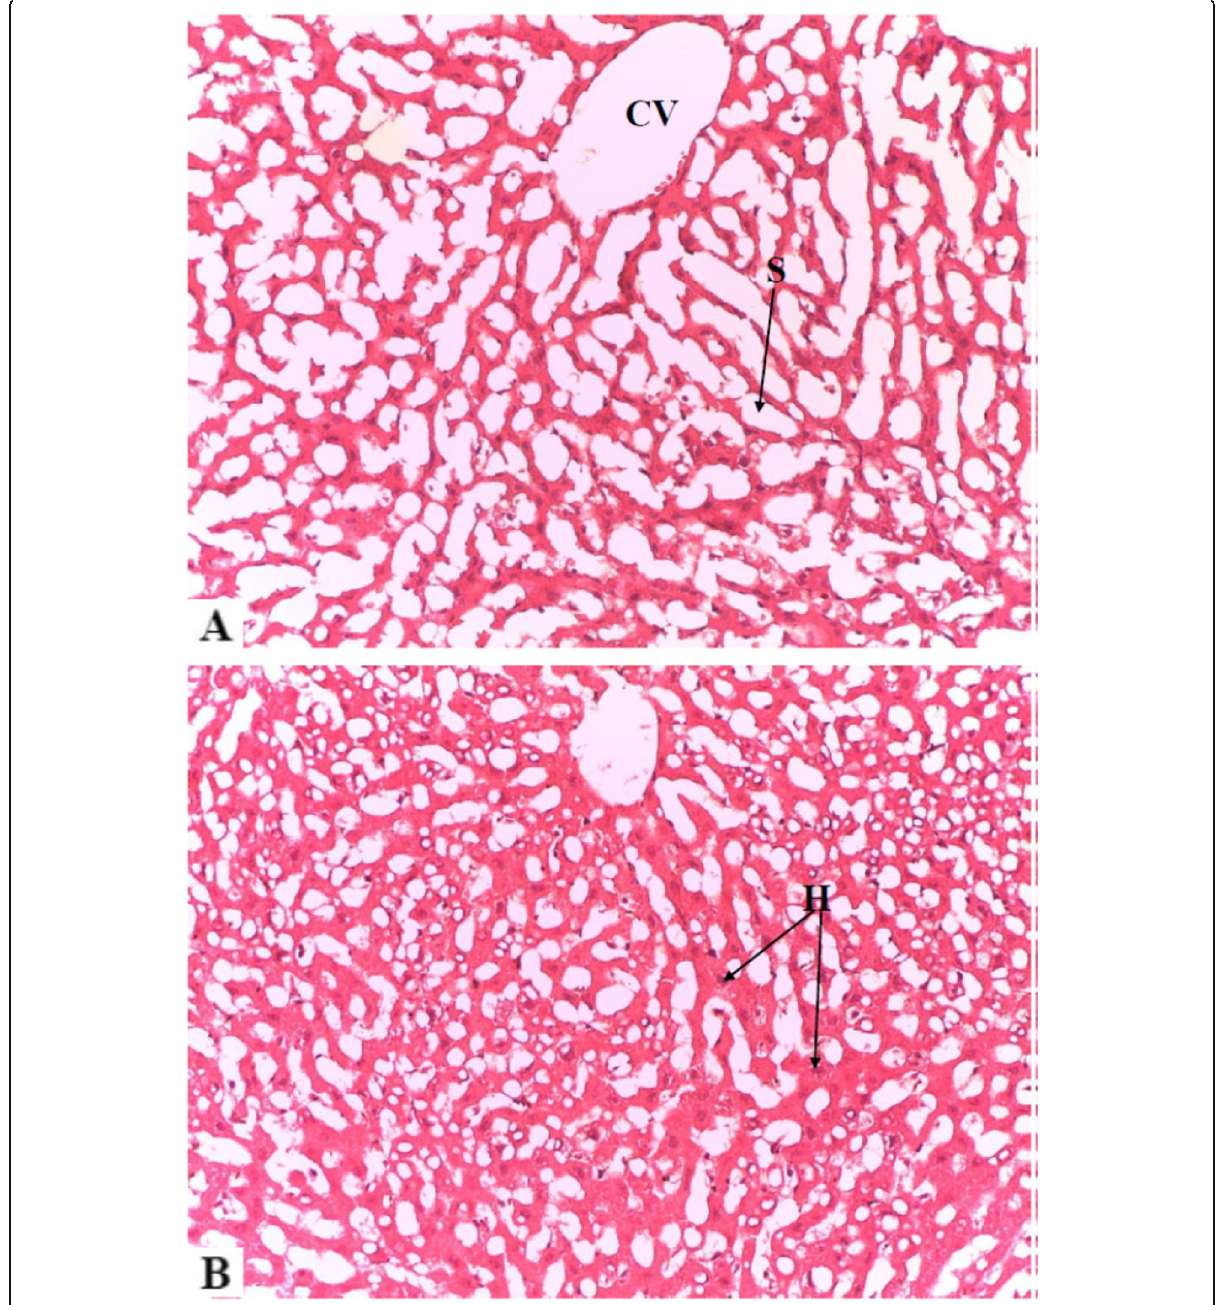
Fig. 7 Photomicrographs of liver section of rat administered ethanolic fruits ’ extract of X. aethiopica (100 mg/kg bw) showing normal sinusoids (S), hepatocytes (H) and central vein (CV). Some areas around the periportal region appear to be mildly